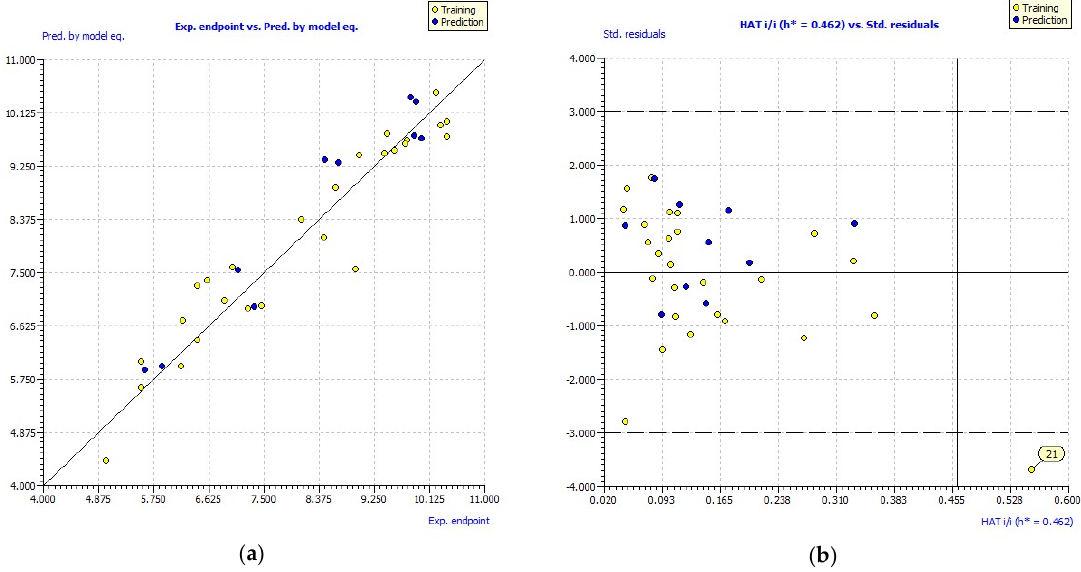
Figure 2. ( a ) Experimental vs. predicted pEC 50 values computed by GA-MLR. ( b ) Williams plot.